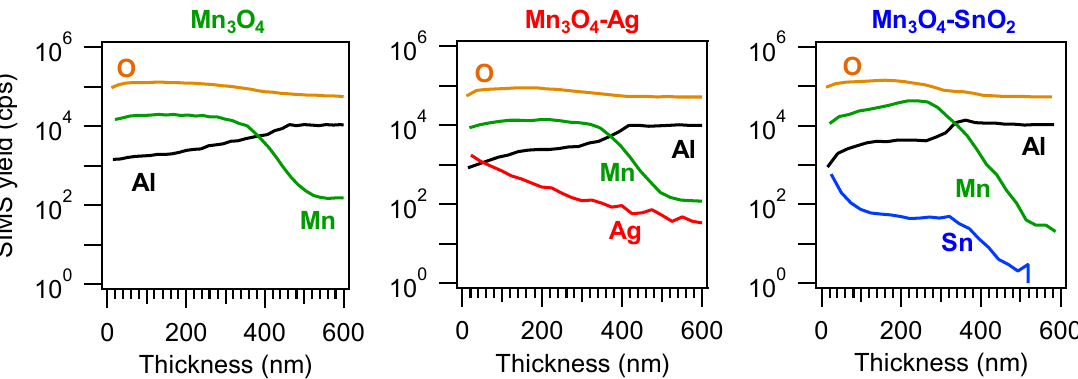
Figure 4. Secondary ion mass spectrometry (SIMS) depth profiles for Mn 3 O 4 , Mn 3 O 4 -Ag and Mn 3 O 4 -SnO 2 specimens.